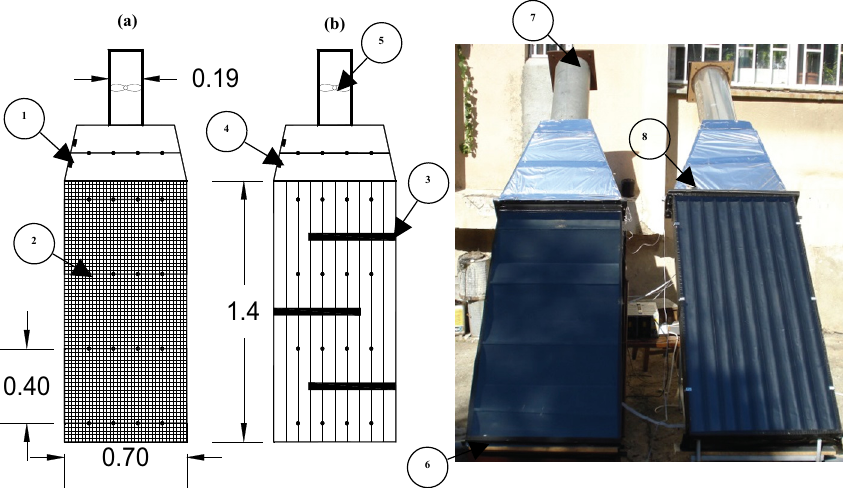
Fig. 1. The experimental set-up and the schematic assembly of the solar air heater with (a) mesh (porous) absorber and (b) “ U ” -corrugated absorber; (1) humidity transducer, (2) thermal transducers, (3) fi n, (4) pressure transducer, (5) fan, (6) air inlet, (7) air outlet and (8) pyranometer.